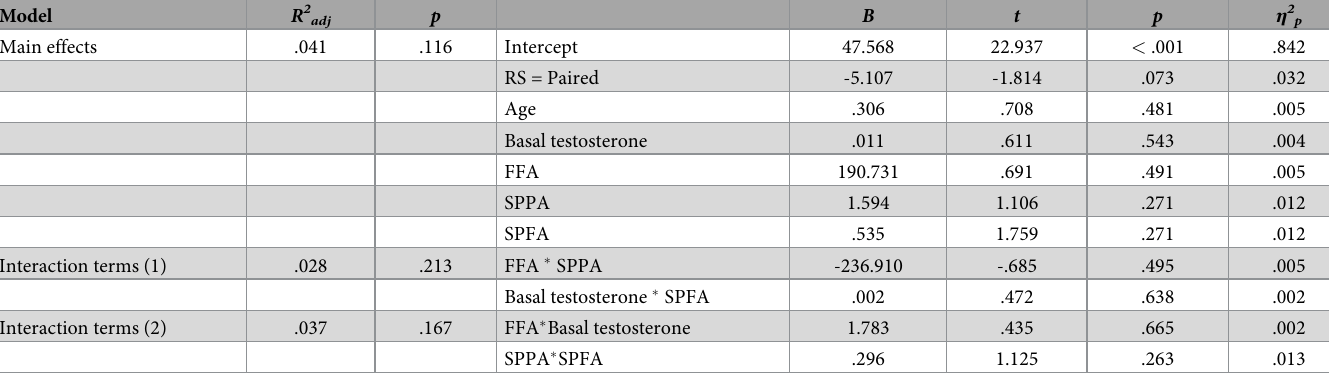
we did not find that the interaction terms were significant, that is, basal testosterone levels did not moderate the predicted relationship between fluctuating facial asymmetry and unrestricted sociosexual orientation ( B = 1.783, t = .435, p = .665), and self-perception of fighting ability did not moderate the predicted relationship between self-perception of physical attractiveness and unrestricted sociosexual orientation ( B = .296, t = 1.125, p = .263). Overall, our results with the reduced data set showed that no variable was related to unrestricted sociosexual orien- tation neither when considering main effects nor the predicted interactions. When considering the full data set, that is, setting aside the basal levels of testosterone, we found a positive relationship between the self-perception of psychical attractiveness and unre- stricted sociosexual orientation when fitting main effects ( B = 2.074, t = 2.215, p = .028; see Table 3 and Fig 1). However, neither fluctuating facial asymmetry ( B = 208.547, t = 1.104, p = .271) nor self-perception of fighting ability ( B = .195, t = 1.053, p = .293) were related to unre- stricted sociosexual orientation. Moreover, self-perception of psychical attractiveness did not moderate the predicted relationship between fluctuating facial asymmetry and unrestricted sociosexual orientation ( B = -203.254, t = -.945, p = .346). And finally, self-perception of fight- ing ability did not moderate the predicted relationship between self-perception of psychical attractiveness and unrestricted sociosexual orientation ( B = .309, t = 1.742, p = .083). Overall, our results with the full data showed a positive effect of self-perception of psychical attractive- ness over unrestricted sociosexual orientation being the other predicted effects non- significant. Table 2. General linear model for short-term sociosexual orientation considering the reduced data set (N = 106). Model R 2